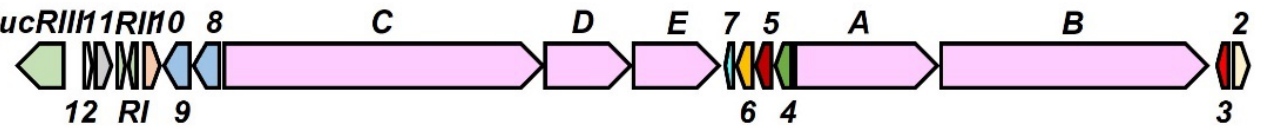
Figure 5. Gene organization of the type I PKS cluster ( luc ) in S. achromogenes subsp. streptozoticus NBRC14001. Table 1. ORFs involved in the Type I PKS cluster ( luc ) in S. achromogenes subsp. streptozoticus